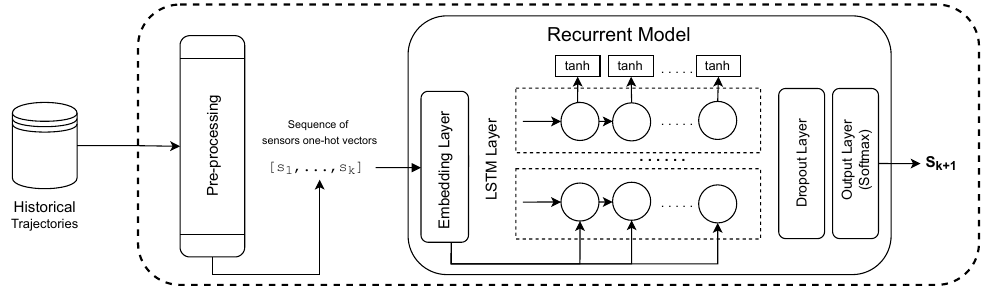
Figure 5. LSTM EST prediction